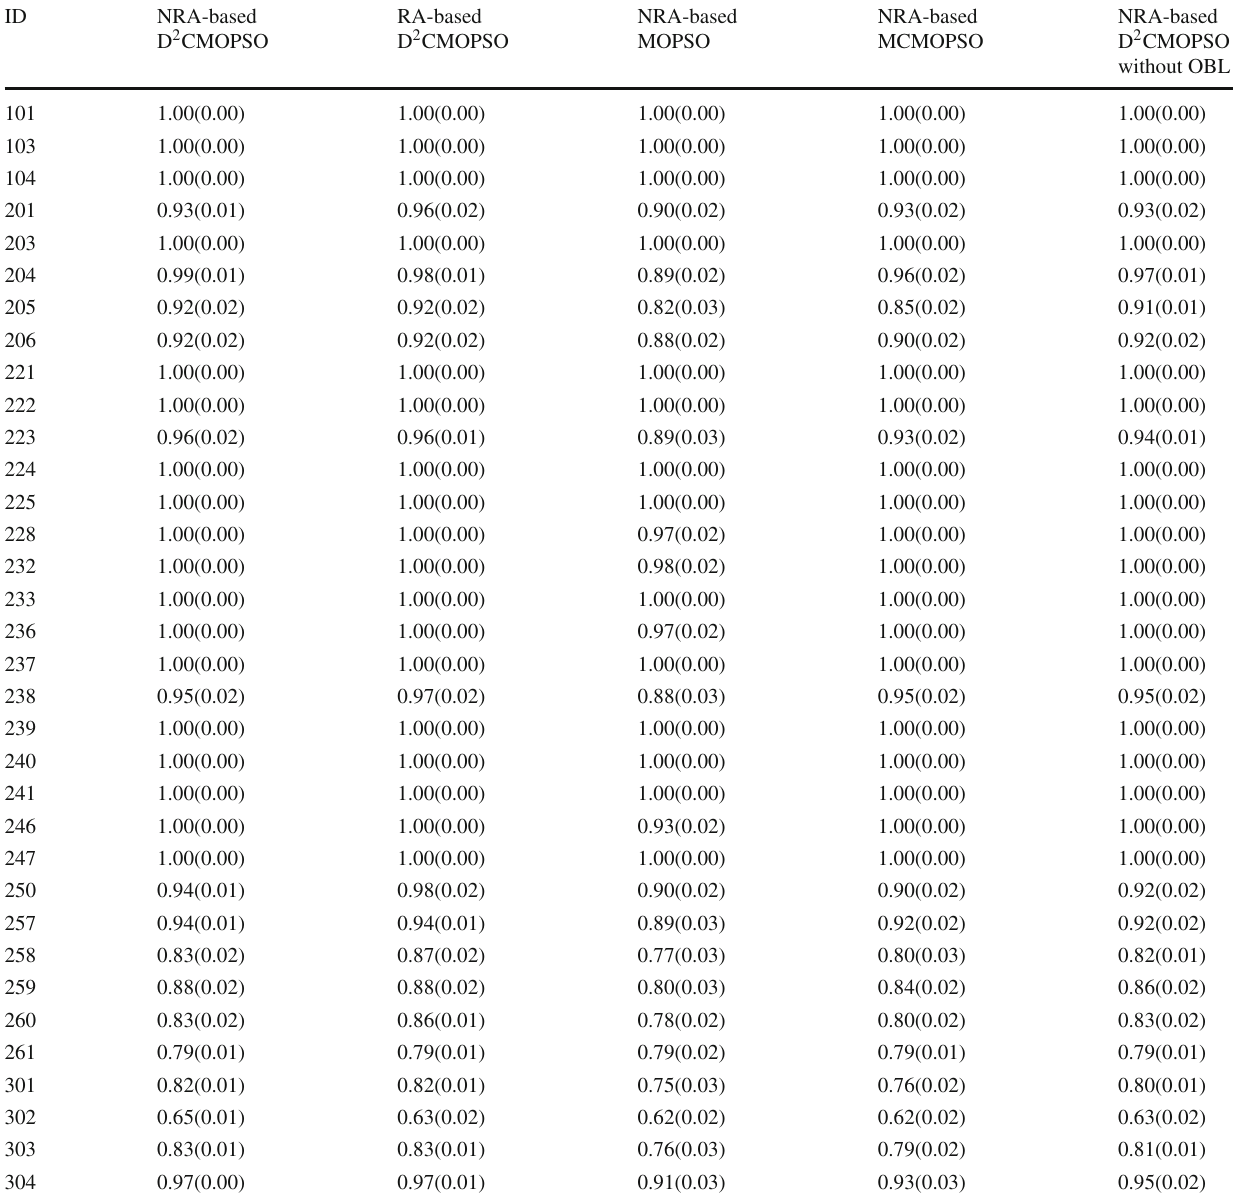
Table 10 Mean and standard deviation of recall for different matching